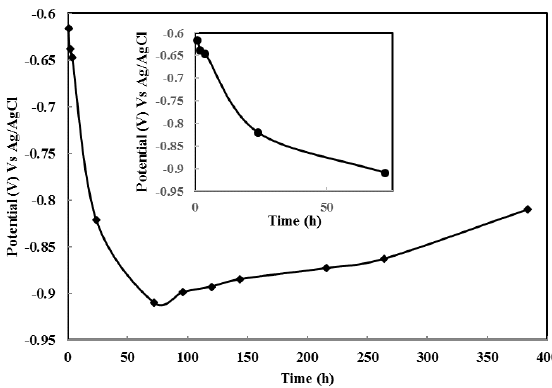
Figure 6. Corrosion potential ‐ time plots of Al coated steel in SAE J2334 solution with exposure periods.